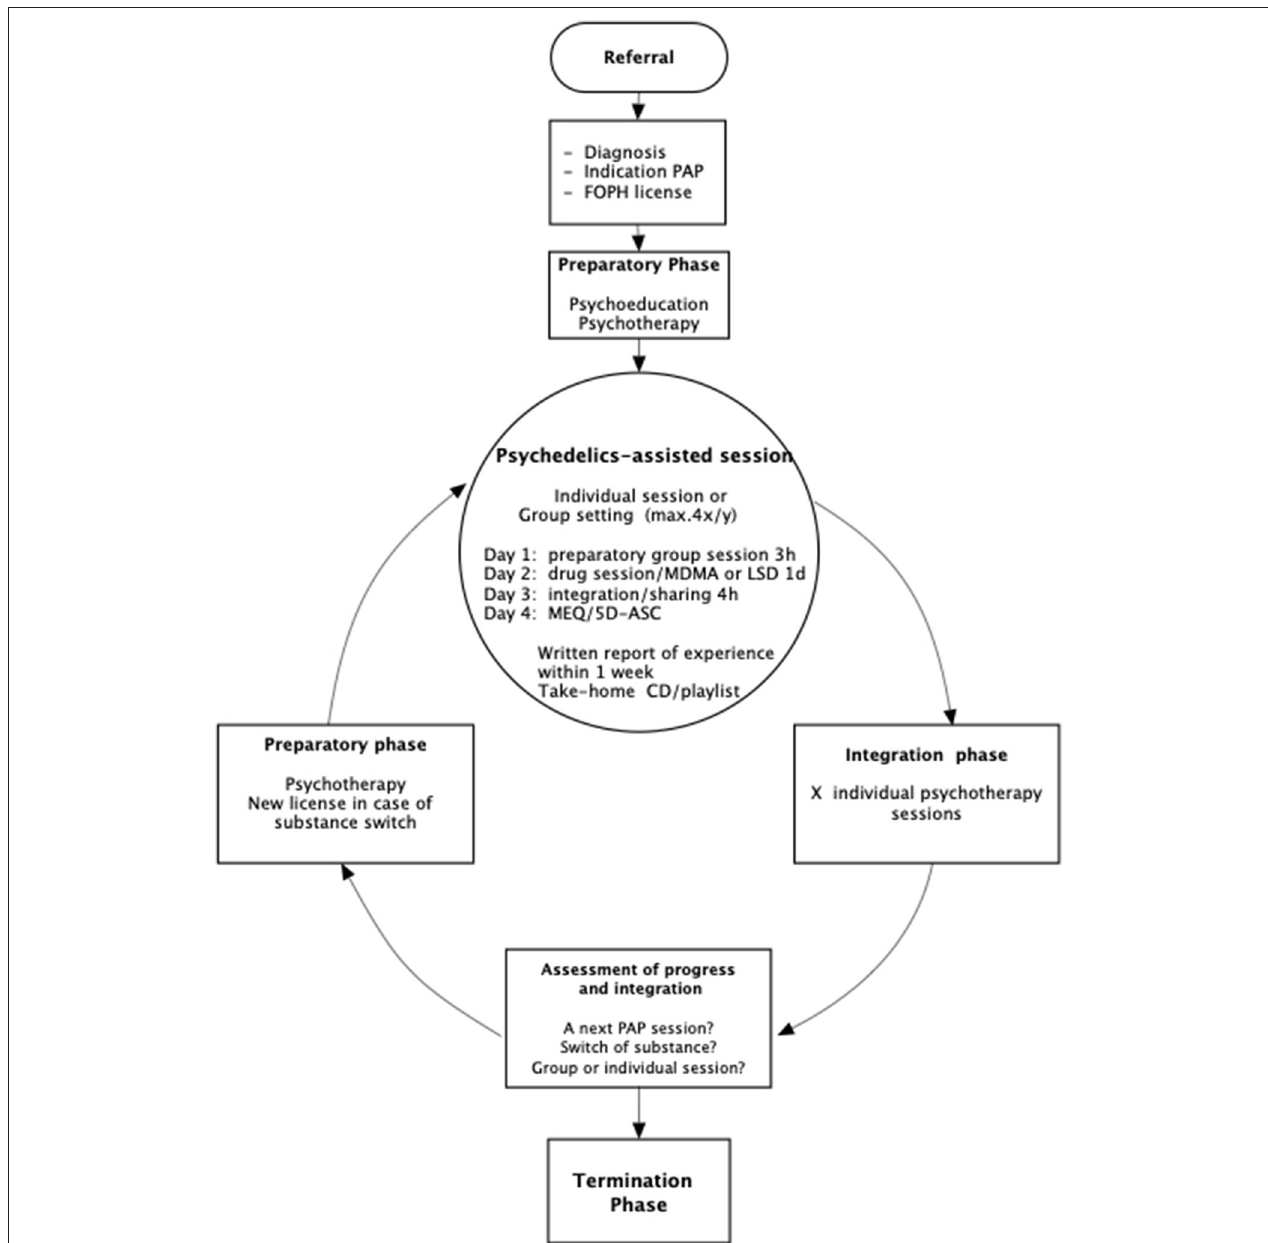
FIGURE 1 | Flow-chart of